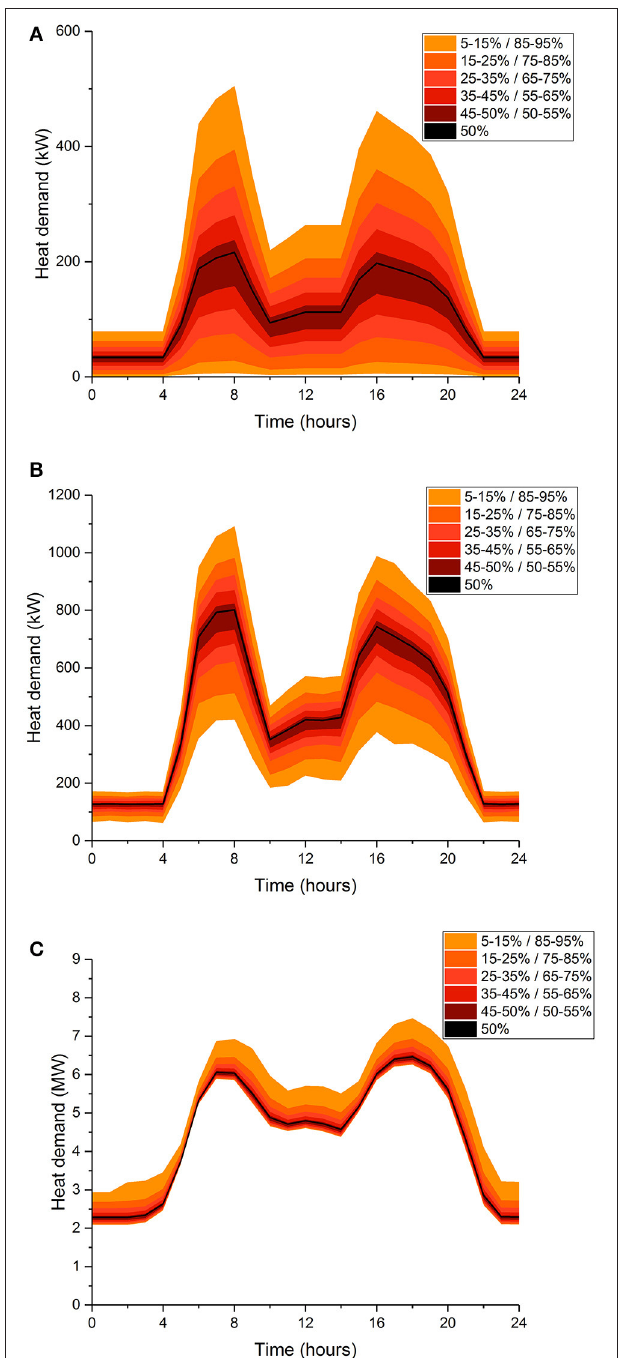
FIGURE 4 | Results of the Monte Carlo simulations for the assumptions in the model, after 1,000 simulations. The mean result, 50th percentile, is shown with a black line. The range of percentiles to the extremes of 5th and 95th are denoted by the color bands. (A) Results of the Monte Carlo simulations for the assumption of each building in an archetype category having the same assumed size (1). (B) Results of the Monte Carlo simulations for the assumption of each building in an archetype category having the same, assumed heat demand profile (2). (C) Results of the Monte Carlo simulations for the assumption that the pipe network travels in the shortest possible straight line distance